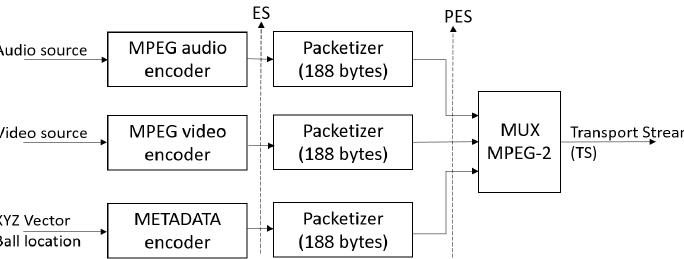
Figure 13. Conformation of the Transport Stream with